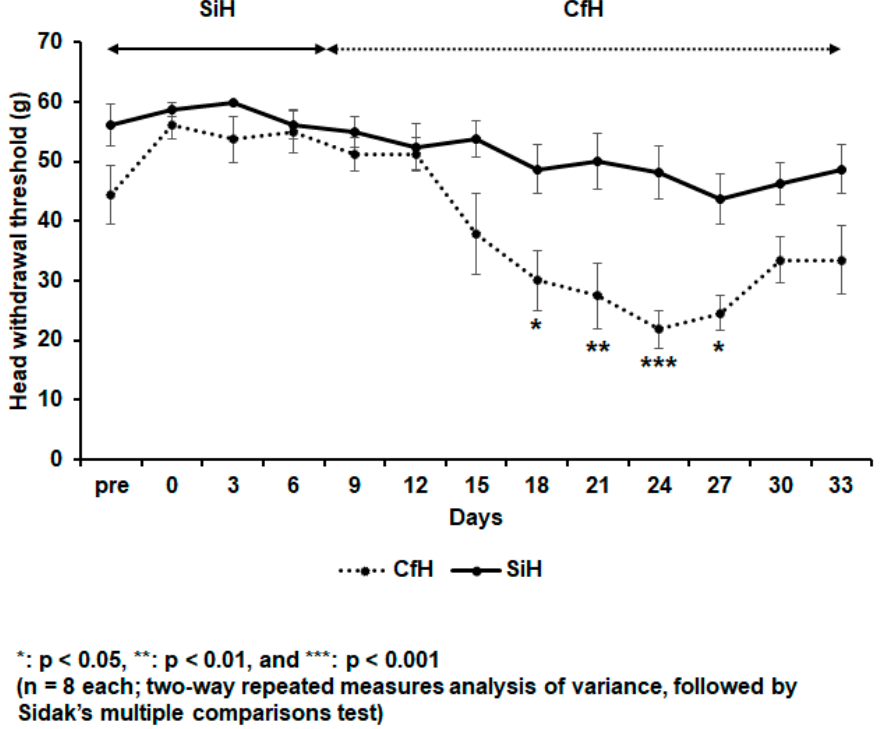
Figure 2. Changes in the HWT in the whisker pad skin over 5 weeks in the SiH and CfH groups. *: p < 0.05, **: p < 0.01, and ***: p < 0.001 vs. the SiH group (two-way repeated measures analysis of variance, followed by Sidak’s multiple comparisons test).